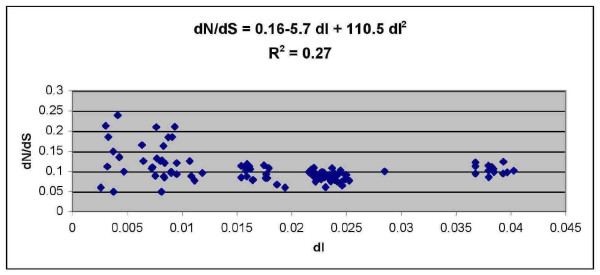
Relationship between the evolutionary ratio (dN/dS) plotted against the number of substitutions for noncoding DNA per site (dI) for all pairwise comparisons within Bovini.